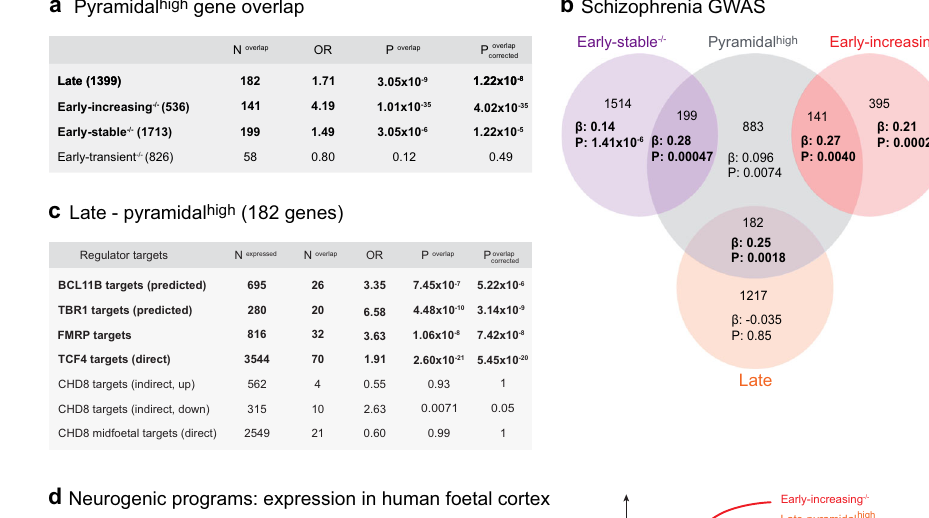
passage 2 at day 20 while cells kept beyond day 40 received a third passage at day 30, 1:2 onto PDL-laminin as previously described. In all cases cells maintained past day 30 were fed with N2B27 + RA supplemented with 2µg/ml laminin once weekly to prevent cell detachment from the culture plates. Immunocytochemistry . Cells were fi xed in 4% paraformaldehyde (PFA, Sigma) in PBS for 20min at 4°C followed by a 1h room temperature incubation in blocking